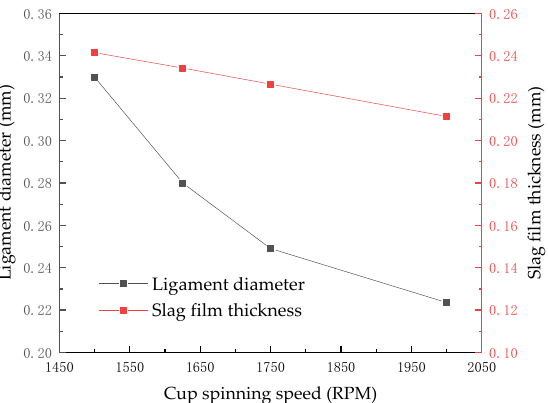
Figure 7. Effect of cup spinning speed on slag film thickness at the cup edge and slag ligament diameter.